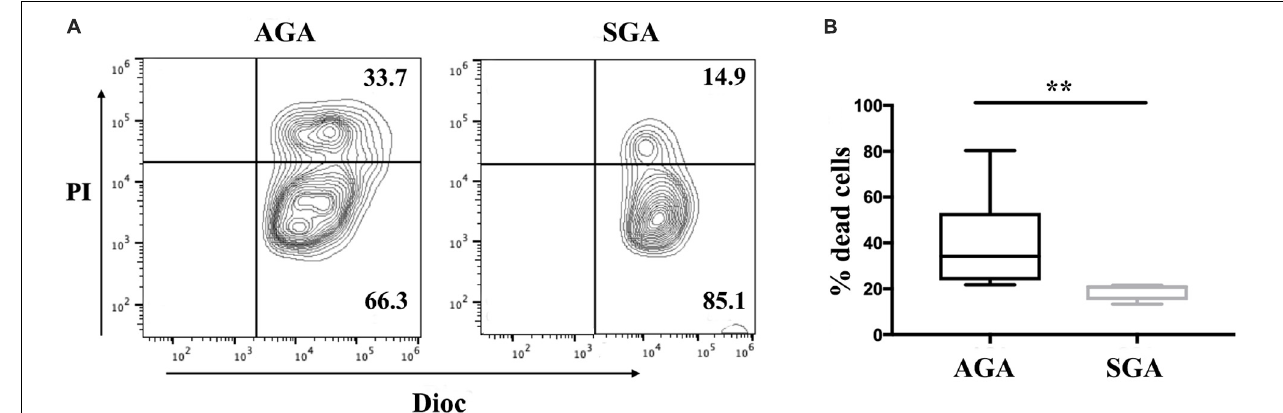
FIGURE 3 | The reduced cytotoxicity of dNK cells in SGA. dNK cells were first incubated with IL-15 (20 ng/ml) for 24 h. Flow cytometry analysis showed the percentage of Dioc + PI + dead K562 cells after gating of Dioc + cells. (A) The cytotoxicity of dNK cells from SGA and AGA against K562. Data show a representative experiment in a single individual from each group. (B) Statistical analysis of the cytotoxicity of dNK cells in SGA ( n = 5) and AGA ( n = 9). ** p < 0.005.